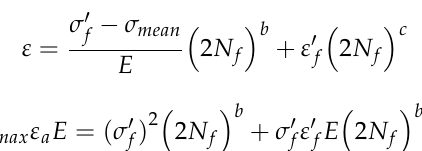
Figure 2. Process flow of acceleration-strain conversion.